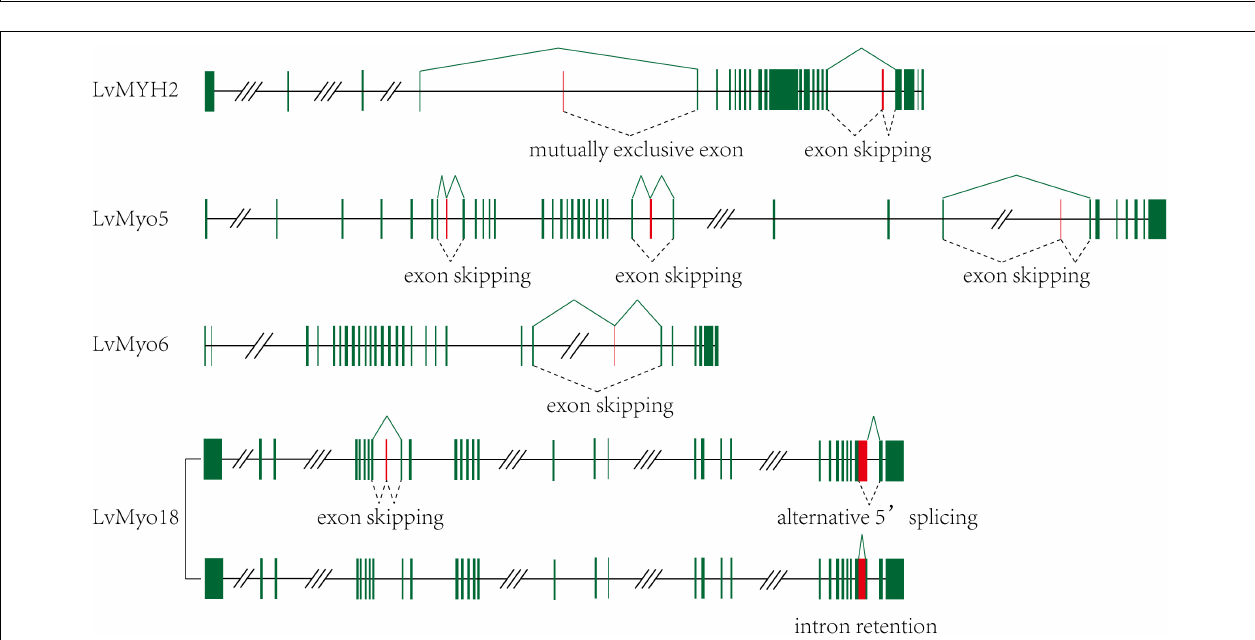
FIGURE 4 | Myosin gain and loss in arthropod species. Tree on the left illustrates the phylogenetic relationships of species used (no scale). Colored boxes indicate the presence of certain myosin subfamily members in each species. Empty boxes mean the potential loss of particular myosin genes.